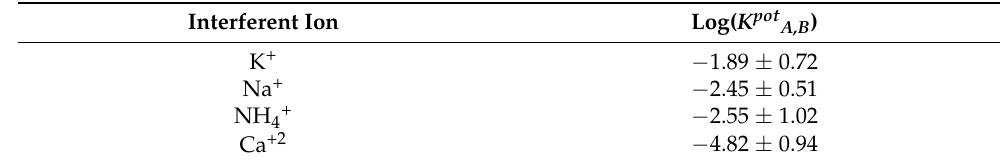
Table 5. The selectivity coefficients (log K pot A,B ) of lithium sensors for different interfering ions obtained by fixed-interference